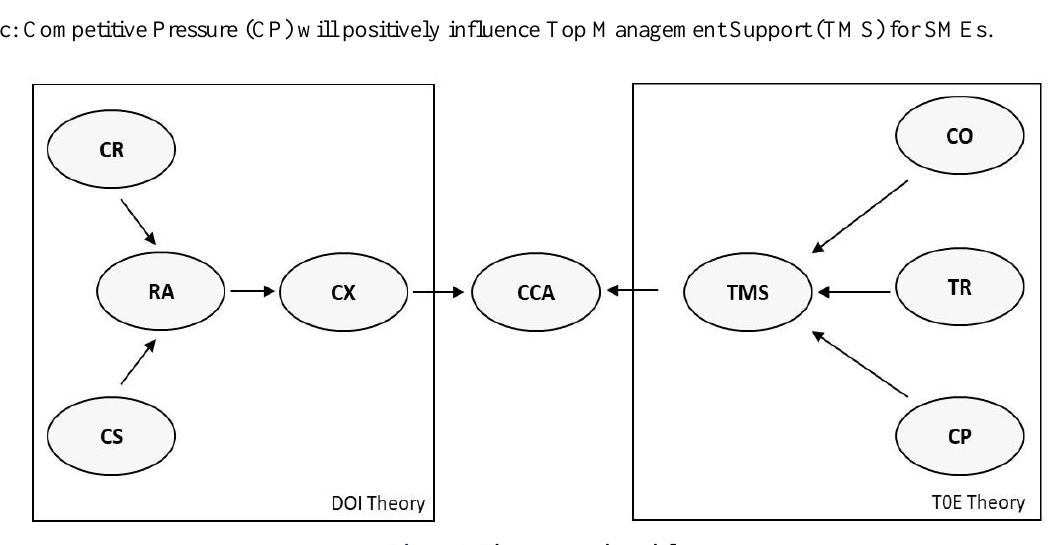
Figure 1. The proposed